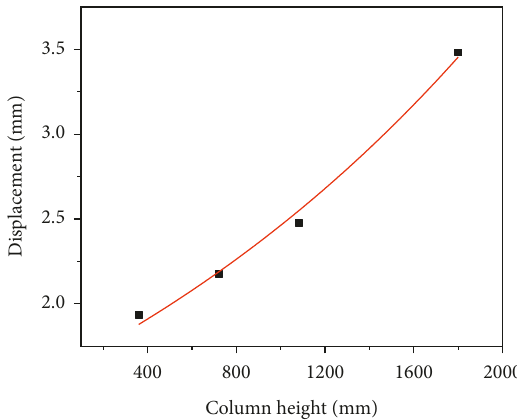
Figure 7: Displacement changing trend.